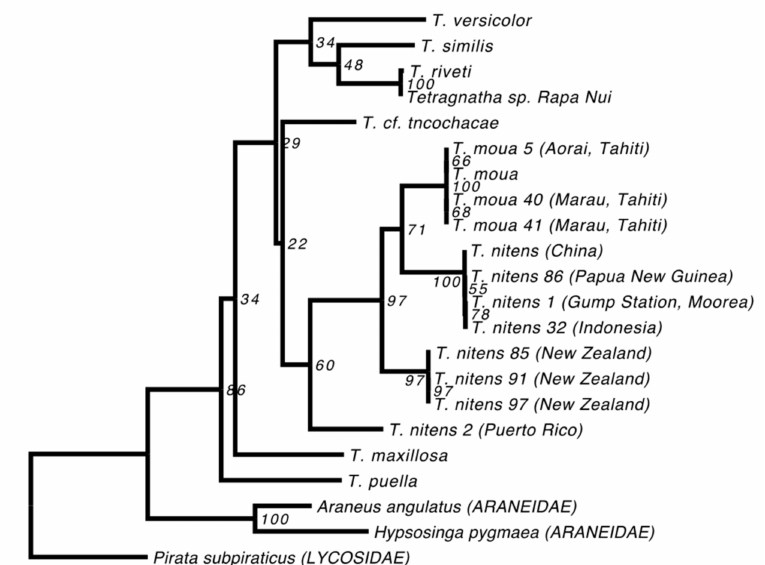
Figure 3. Maximum likelihood reconstruction including extra populations of T. nitens and specimens of T. moua . The reconstruction was done using the strict consensus sequences of COI . The T. moua and T. nitens specimens marked with asterisk correspond to the ones used on Figure